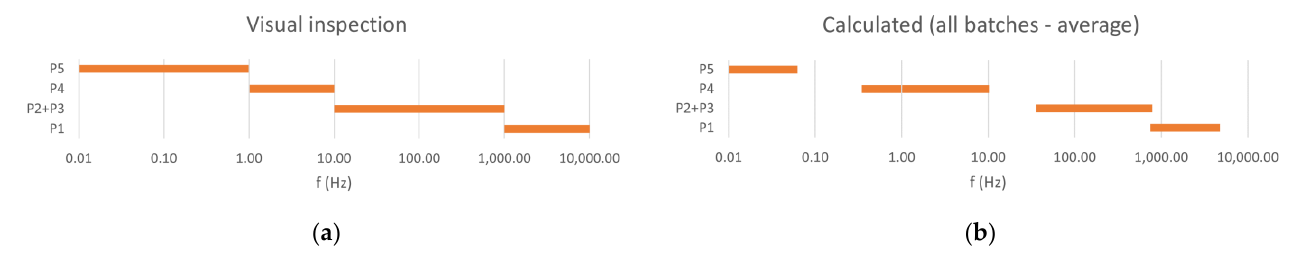
Table 3. Frequency ranges calculated for each batch at every parameter variation.